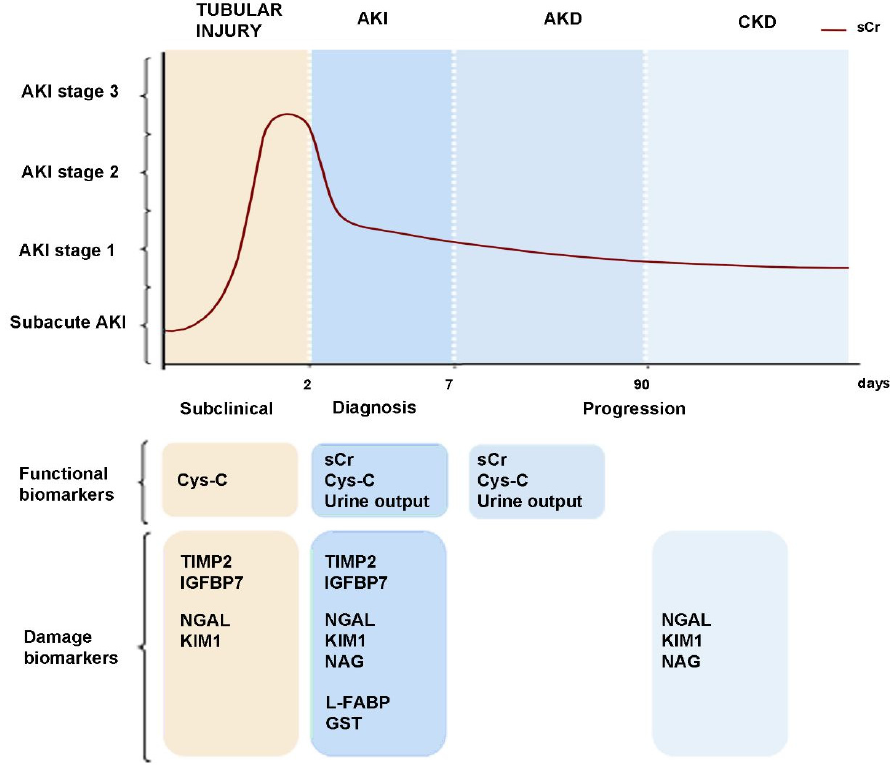
Figure 3. Biomarkers’ detection in AKI, AKD, and CKD. Among the currently used biomarkers, only a few of them are detected early during AKI progression, before a rise in the serum creatinine (sCr) is present. These markers indicate early tubular injury or subclinical acute kidney injury (AKI). AKI itself is recognized by both functional and damage biomarkers, whereas the stages of AKI are defined by the extent of kidney function impairment represented by sCr rise. AKI accompanied by prolonged tubular damage is defined as acute kidney disease (AKD). When the injury is extended and irreversible, and kidney function cannot be restored, it leads to chronic kidney disease (CKD). Abbreviations: Cys-C, cystatin C; IGFBP-7; insulin-like growth factor-binding protein 7; TIMP-2; metalloproteinase inhibitor 2; GST: Glutathione S-transferase; NAG: N-Acetyl- Beta-D-Glucosaminidase; NGAL: Neutrophil Gelatinase-Associated Lipocalin; KIM-1: Kidney Injury Molecule-1; L-FABP: Liver-type Fatty Acid-Binding